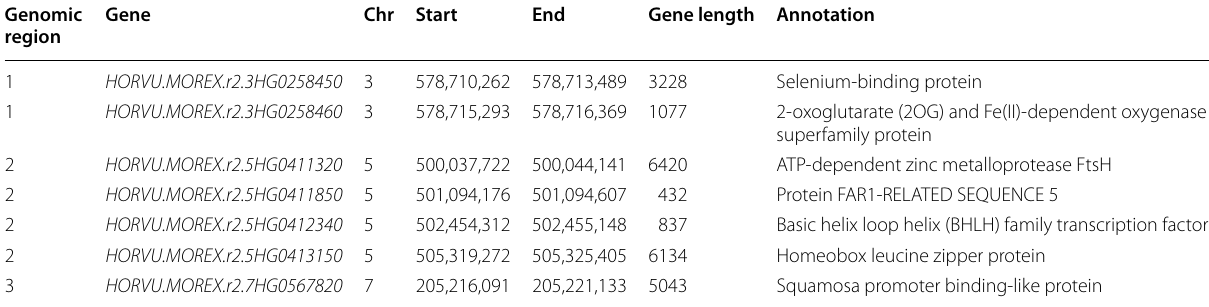
Table 1 The list of candidate genes based on the linkage disequilibrium of multi‑traits associated marker Genomic Gene Chr Start End Gene length region